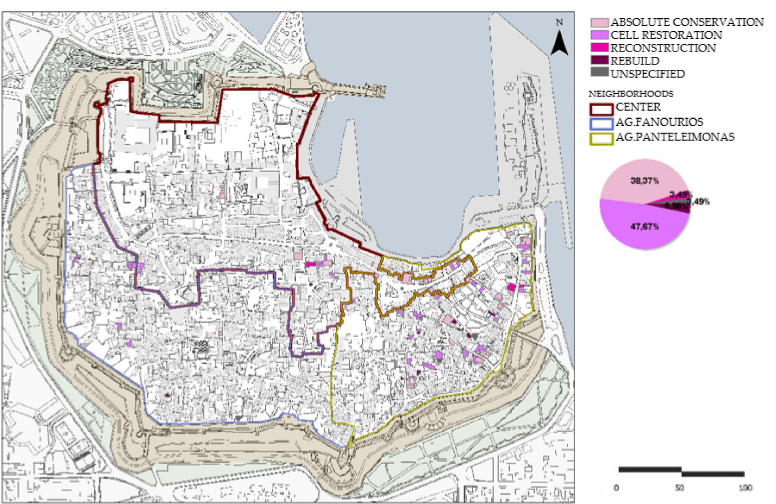
Figure 24. Restoration proposal (absolute conservation, cell restoration, reconstruction, demolish and